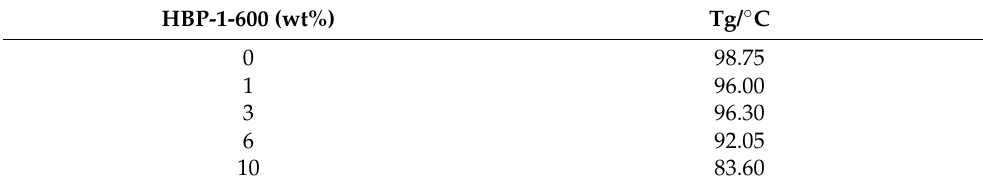
Figure 4. E’ ( a , c ) and tan δ ( b , d ) of the neat UPR and the UPR composites. Table 4. Glass transition temperature (Tg) of UPR at different HBP-1-600